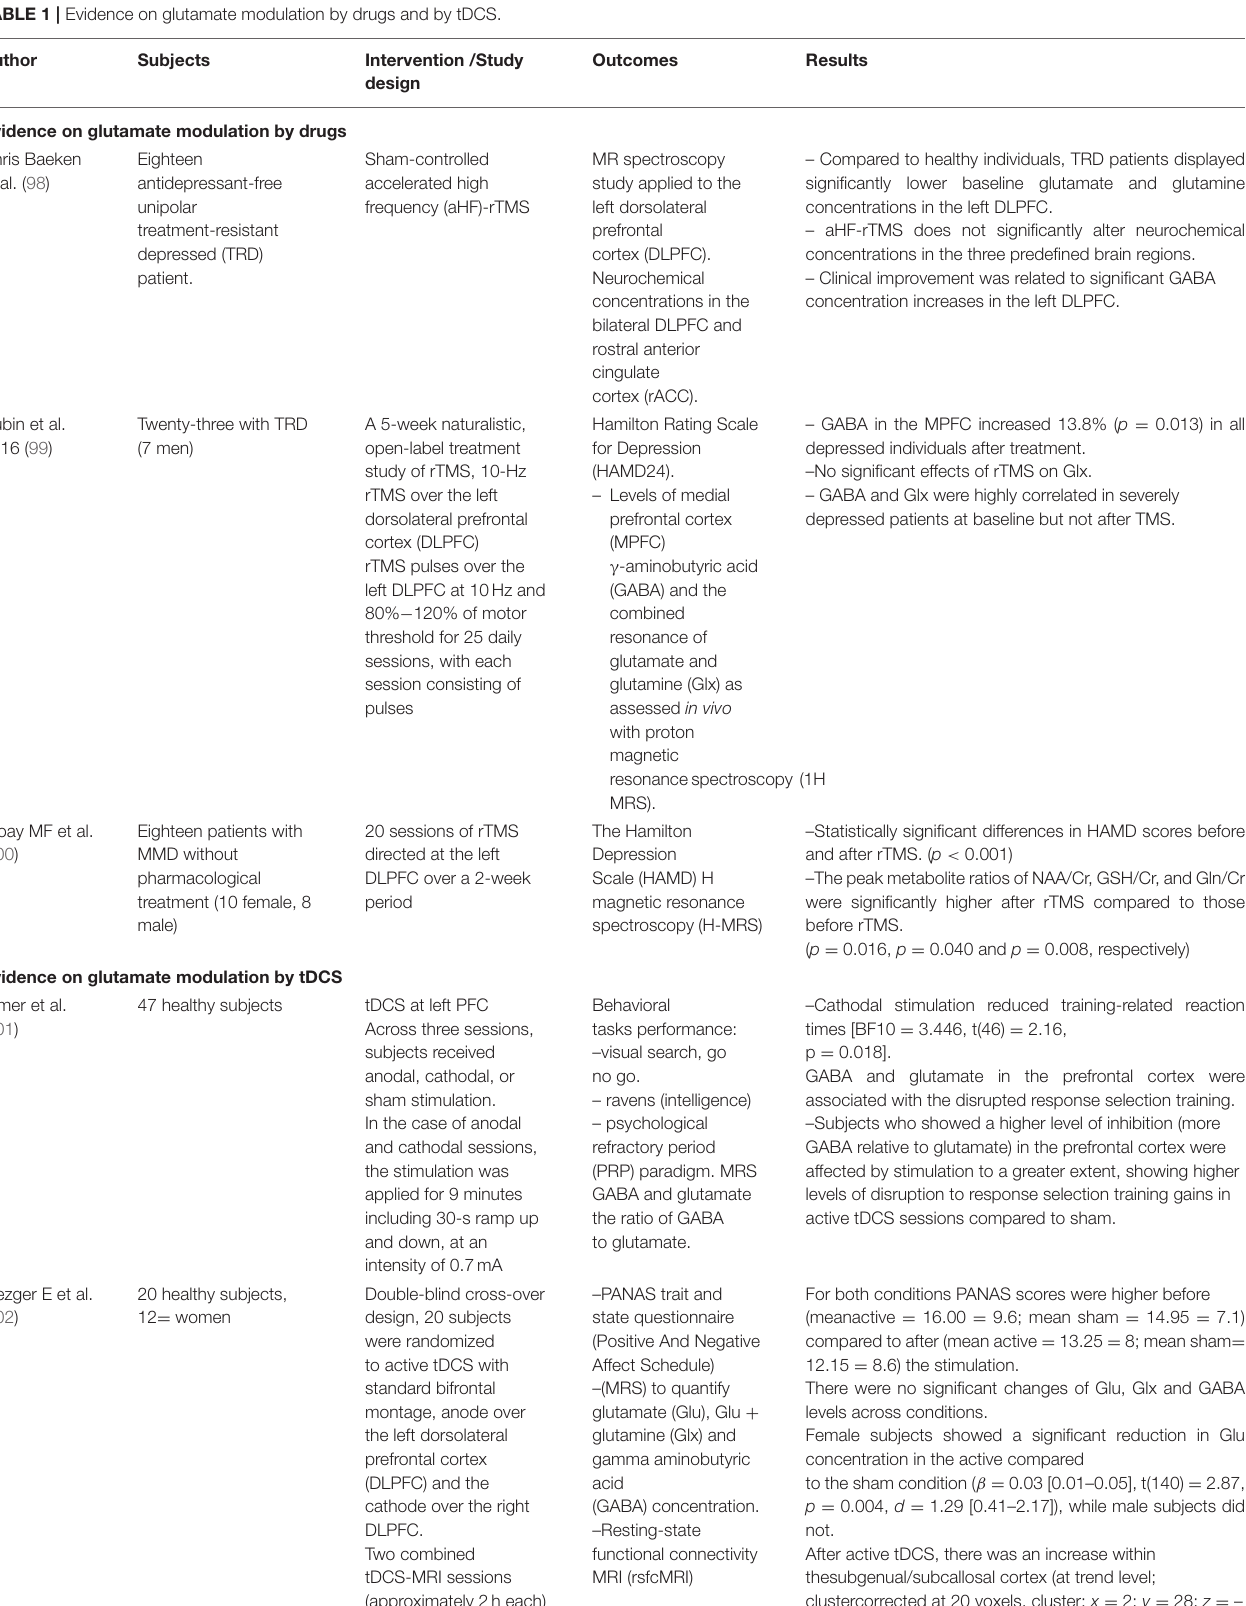
TABLE 1 | Evidence on glutamate modulation by drugs and by